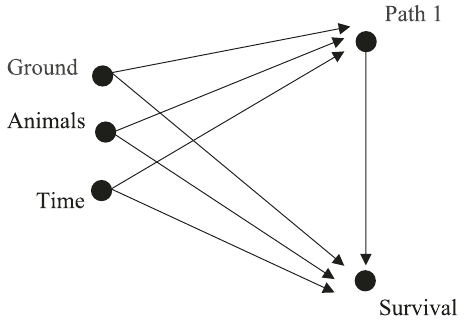
Fig. 3 How the diagram changes through the introduction of the do- operator. This diagram describes the behavior of the affective systems involved in